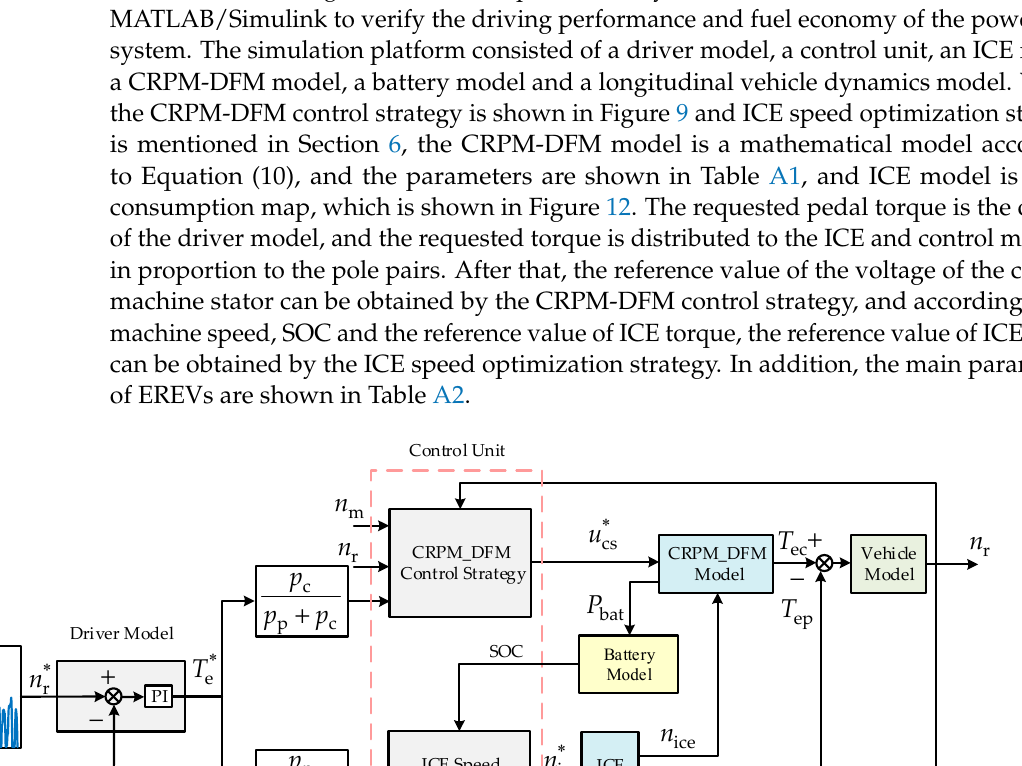
Figure 13. Flowchart of the ICE speed optimization strategy.